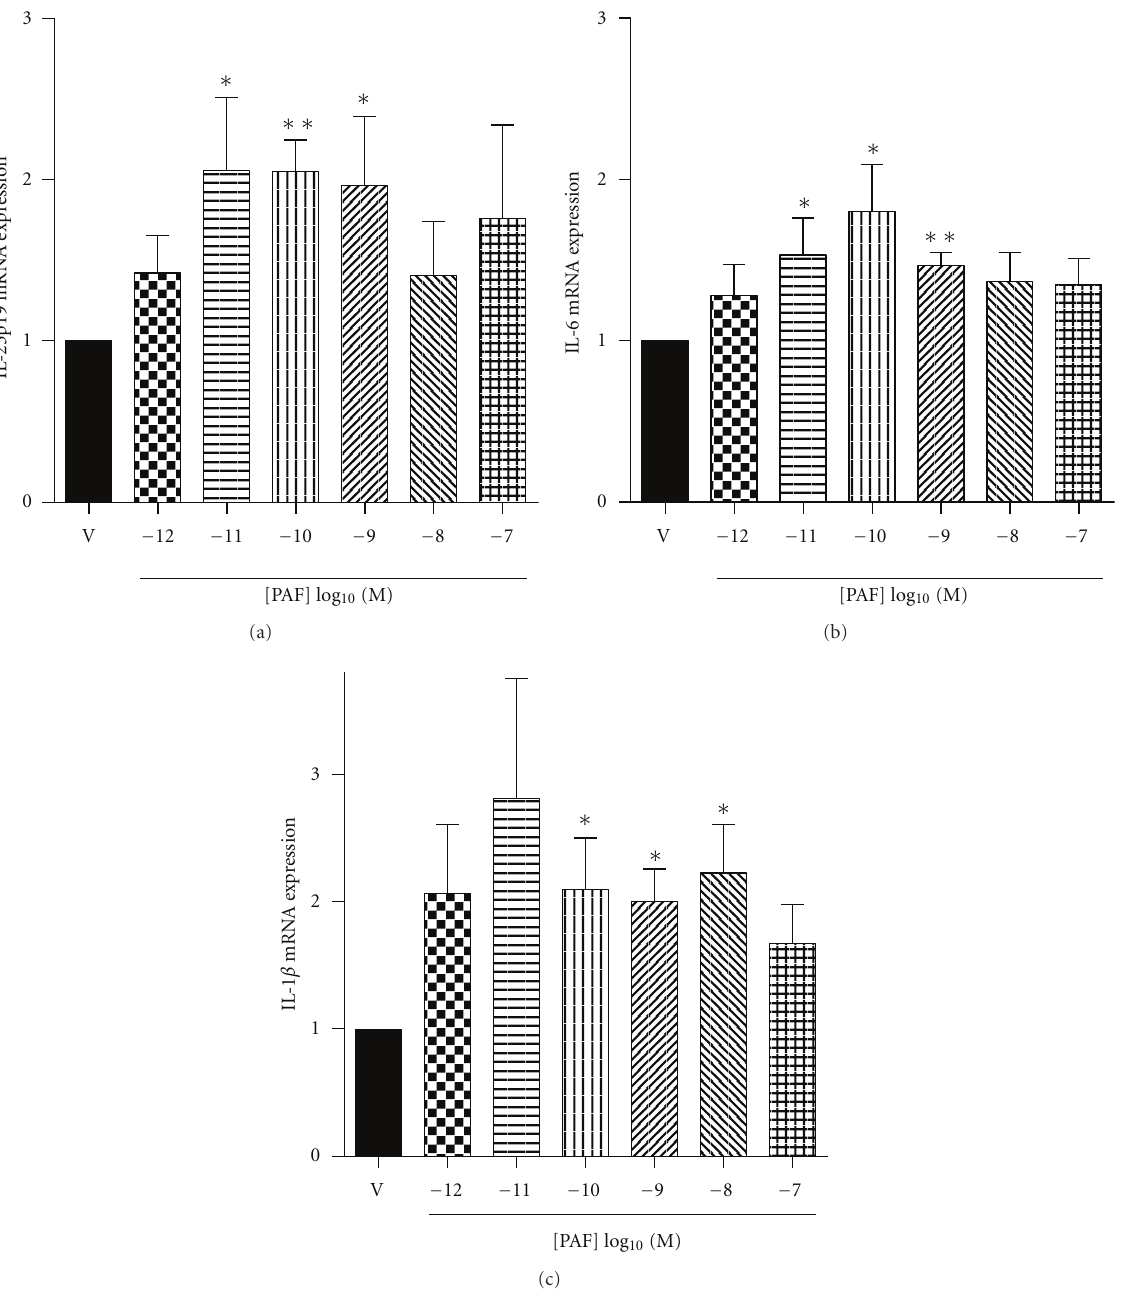
Figure 1: PAF-induced IL-6 and IL-23p19 mRNA expression in LC. Monocyte-derived LC were stimulated with graded concentrations of PAF or its vehicle (ethanol; V) for 4h. IL-23 p19 (a), IL-6 (b), and IL-1 β (c) mRNA was then measured by real-time quantitative PCR. Data (means ± SEM) are expressed as fold induction relative to vehicle control. n = 9; ∗ P < 0 . 05; ∗∗ P < 0 . 01.